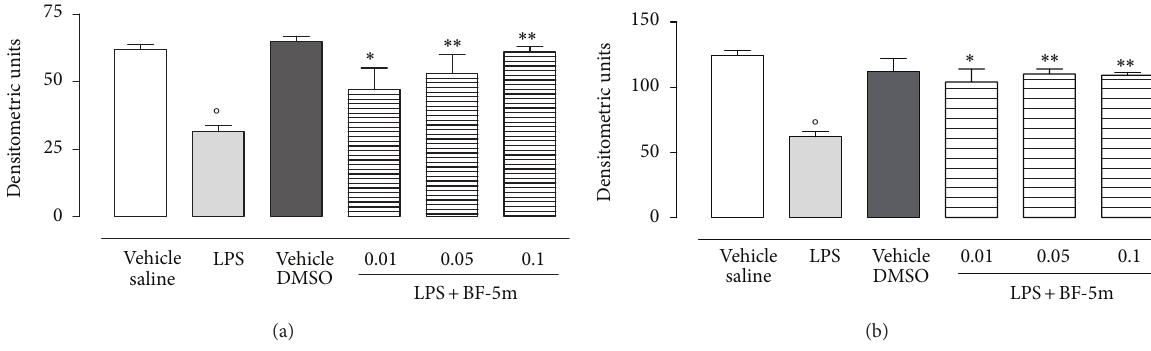
Figure 6: Western blotting analysis for Mn-SOD and GPX. Expression of manganese superoxide dismutase (Mn-SOD) (a) and glutathione peroxidase (GPX) (b) into the vitreous of rats 24h after treatment with LPS or LPS+BF-5m (0.01; 0.05; 0.1 𝜇 M/rat) compound. Densitometric units as calculated from WB traces are expressed as mean ± SEM of 𝑛 = 6 observations for each group. ∗ 𝑃 < 0.05 and ∗∗ 𝑃 < 0.01 versus LPS-treated rats; ∘ 𝑃 < 0.01 versus vehicle saline group.